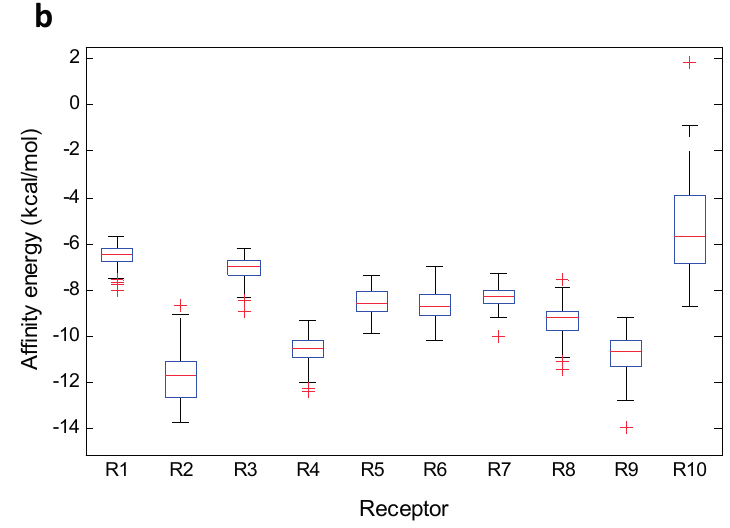
Figure 12. Boxplot for affinity values of the selected xanthone-types. ( a ) MX; ( b )